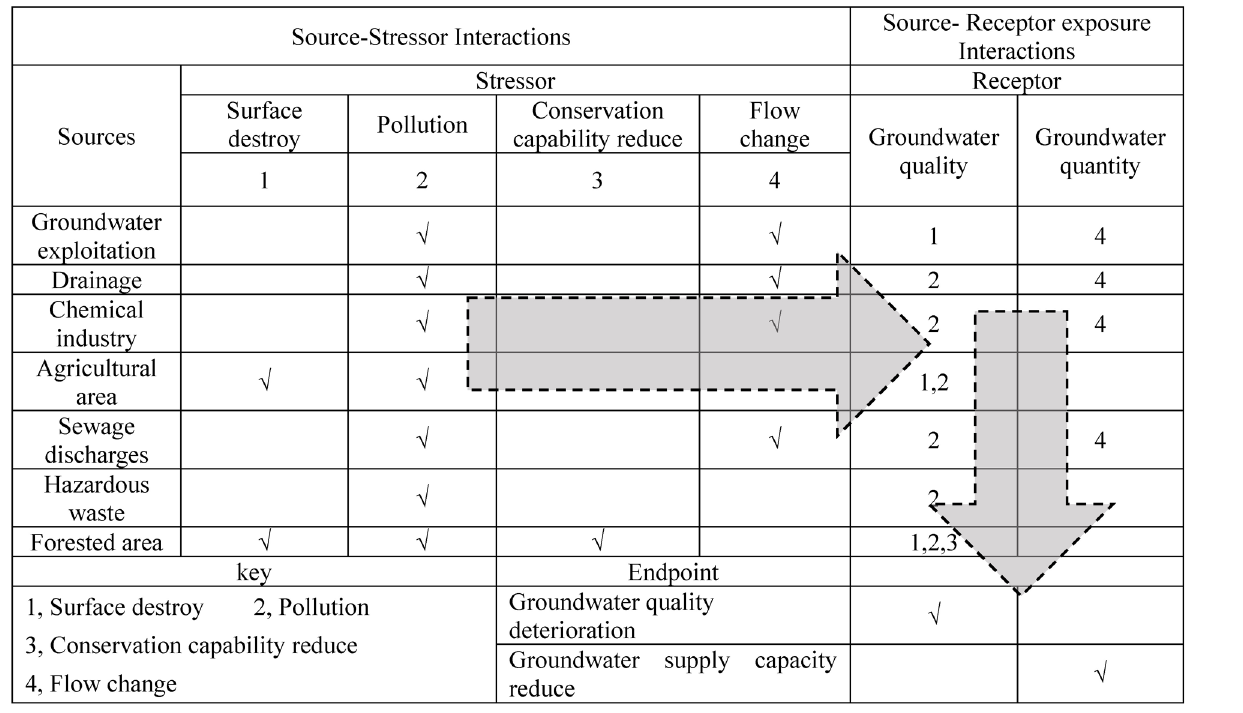
Fig 3. Exposure and response of risk Sources, Receptors, and Endpoints in the regional groundwater conceptual